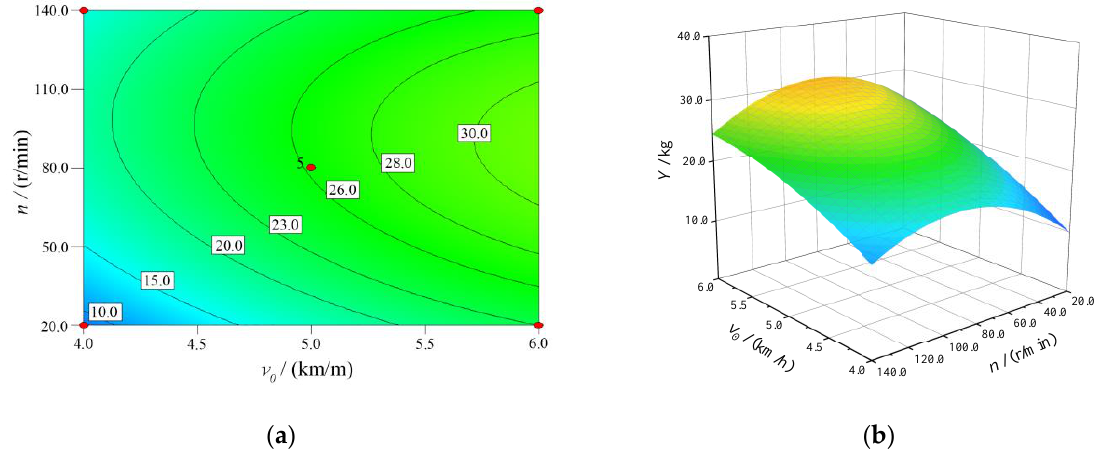
Figure 6. Influence of the forward speed and rotation speed on the soil-hilling quantity. ( a ) Contour map; ( b ) response surface diagram.